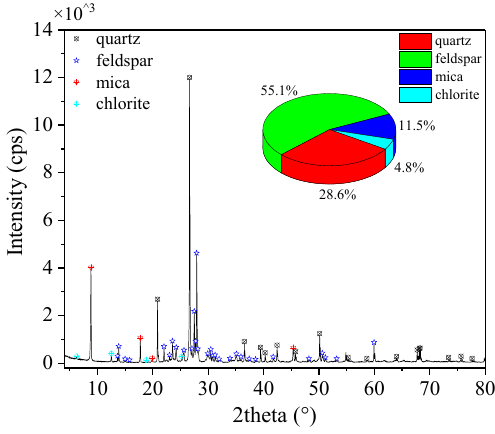
Figure 2. XRD spectrum of granite (20°C).